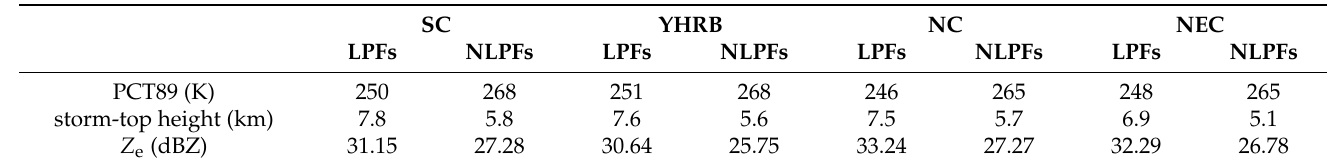
Table 2. Mean PCT89, storm-top height, and reflectivity at 1 km above the SH for LPFs and NLPFs over SC, YHRB, NC and NEC during the summer for the time period